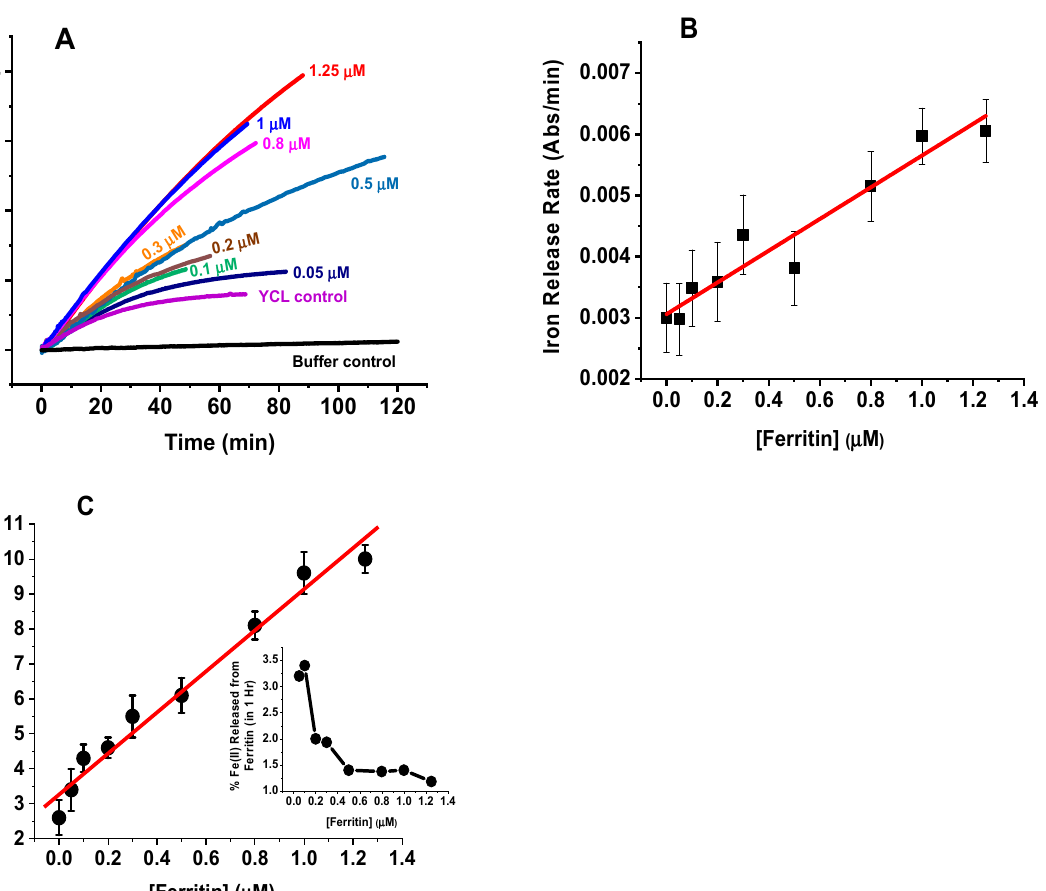
0.0 0.2 0.4 0.6 0.8 1.0 1.2